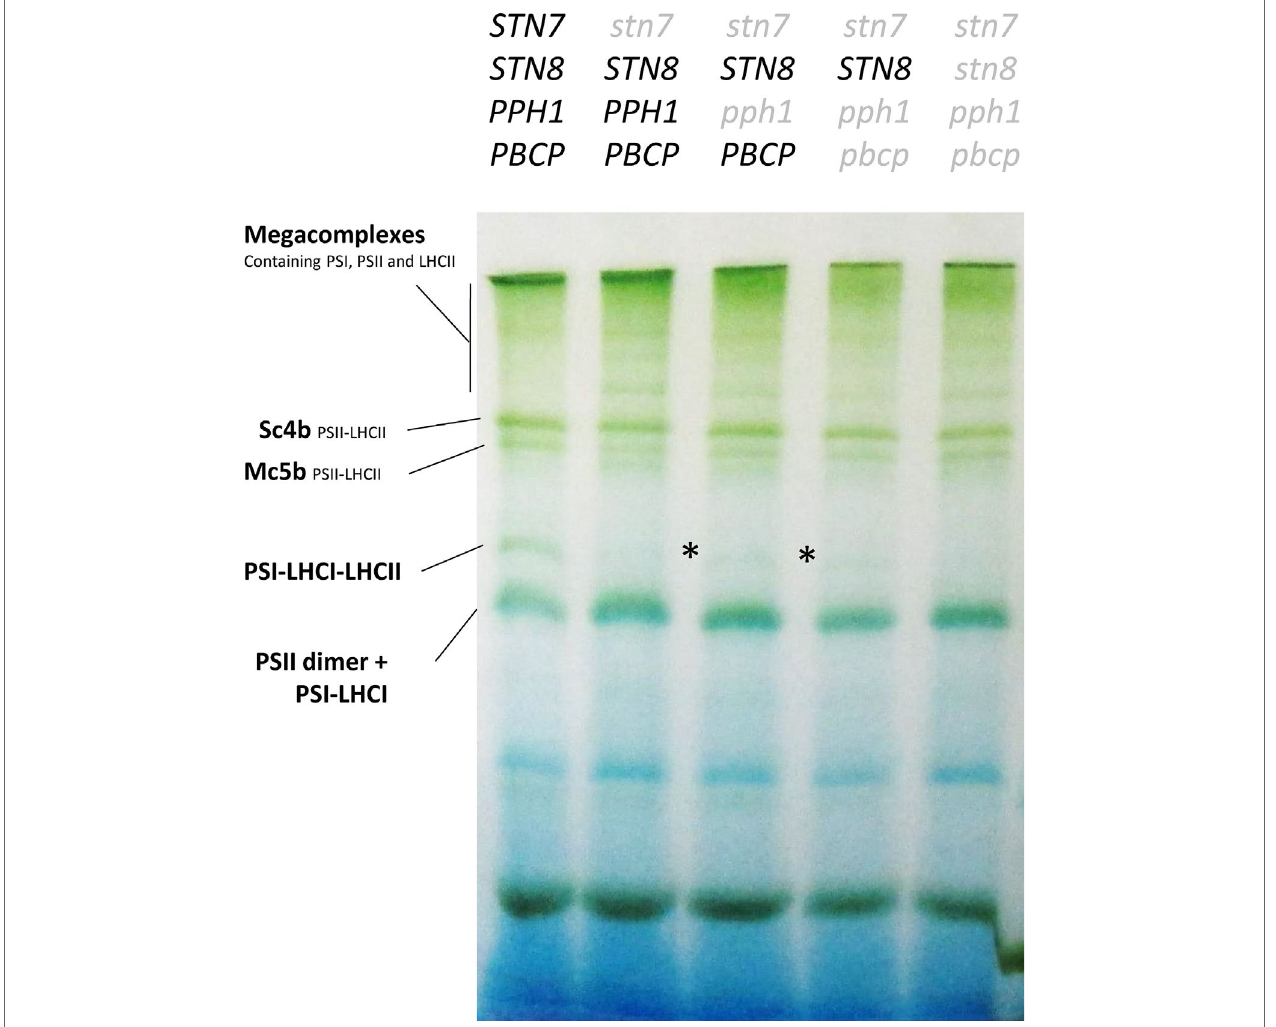
FIGURE 3 | Analysis of supercomplexes from the stroma lamellae of the mutant lines. Supercomplexes were isolated with 1% digitonin from a thylakoid preparation of plants grown under constant light and analyzed by BN-PAGE. This digitonin fraction corresponds to supercomplexes present mostly in the stroma lamellae. The lack of antenna phosphorylation in the stn7 mutant leads to the stabilization of supercomplexes migrating above the PSII-LHCII supercomplex, which are normally not clearly visible in the Col-0 background. These supercomplexes are present also in all the multiple mutants. A partial recovery of the PSI-LHCI- LHCII supercomplex (highlighted with an asterisk) can be observed in both the stn7/ STN8 /pph1/ PBCP mutant and the stn7/ STN8 /pph1/pbcp mutant. This supercomplex is completely absent in the quadruple mutant further lacking the STN8